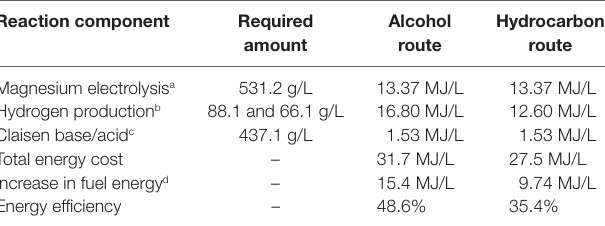
TaBle 2 | Minimum energy cost per liter of butanol fuel produced from methanol and